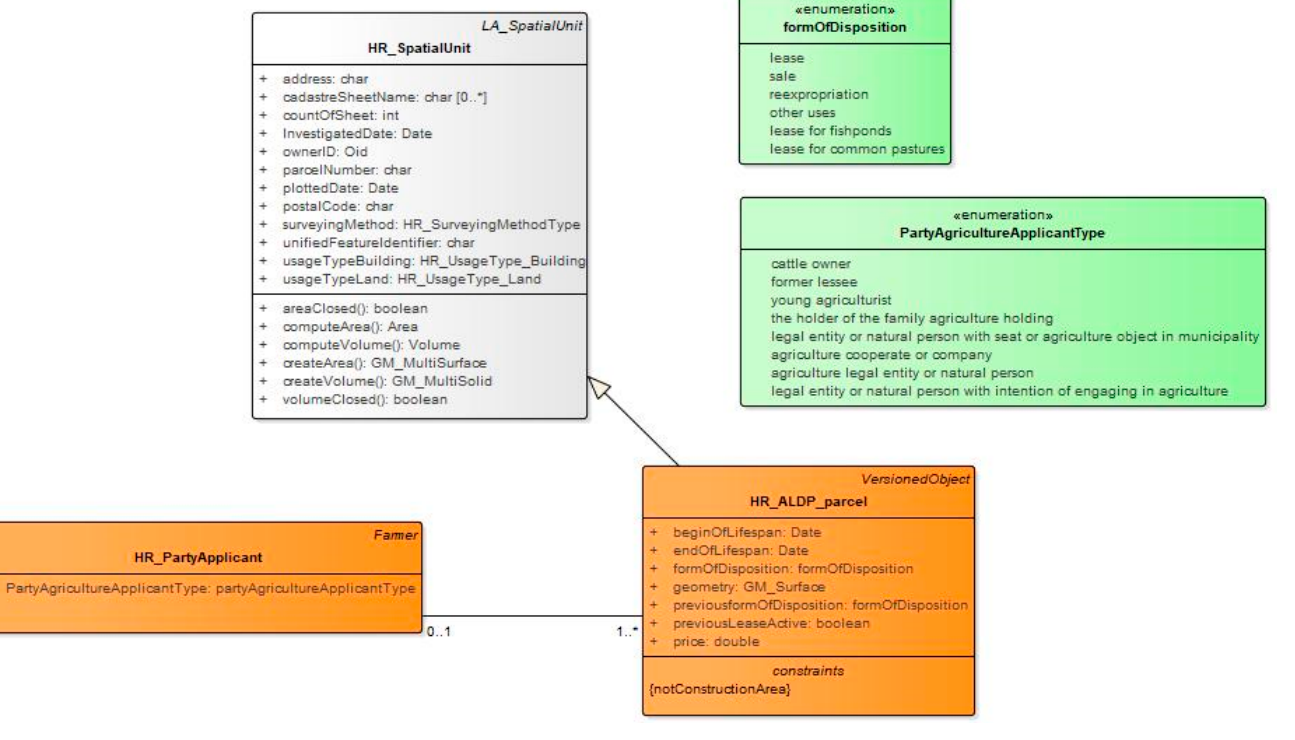
Figure 4. Newly proposed classes and enumerations.